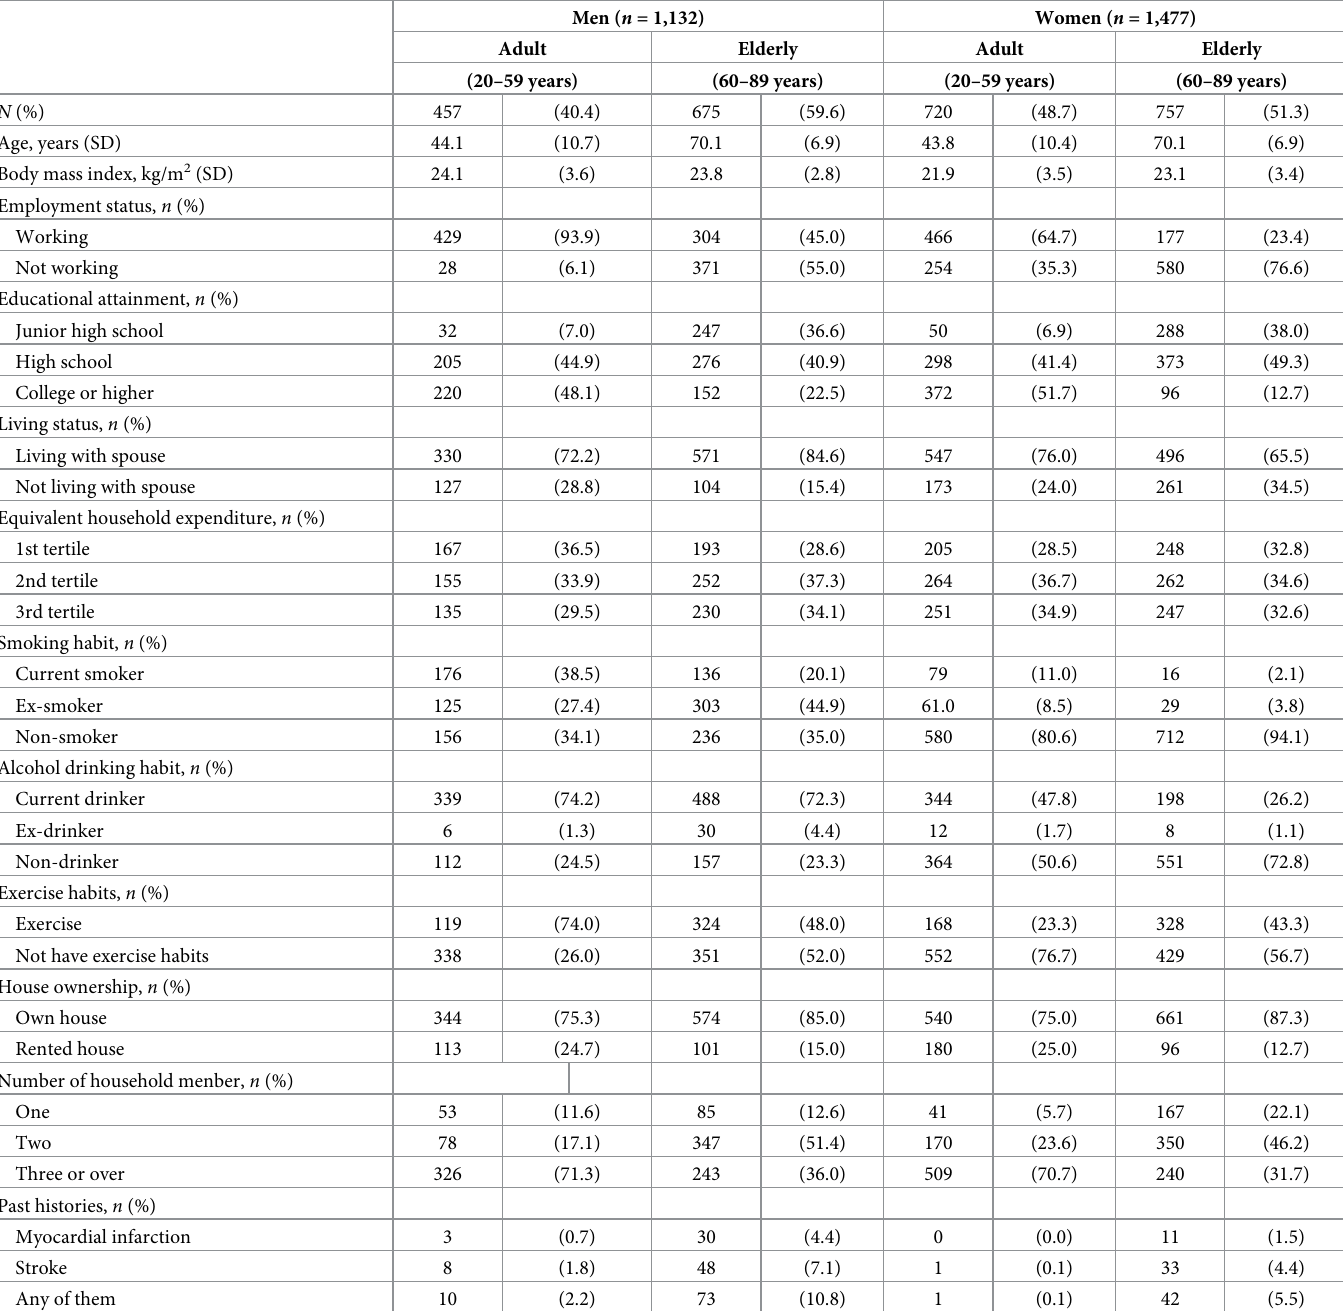
Table 1. Characteristics of study participants by sex and age groups, NIPPON DATA2010, 2010,